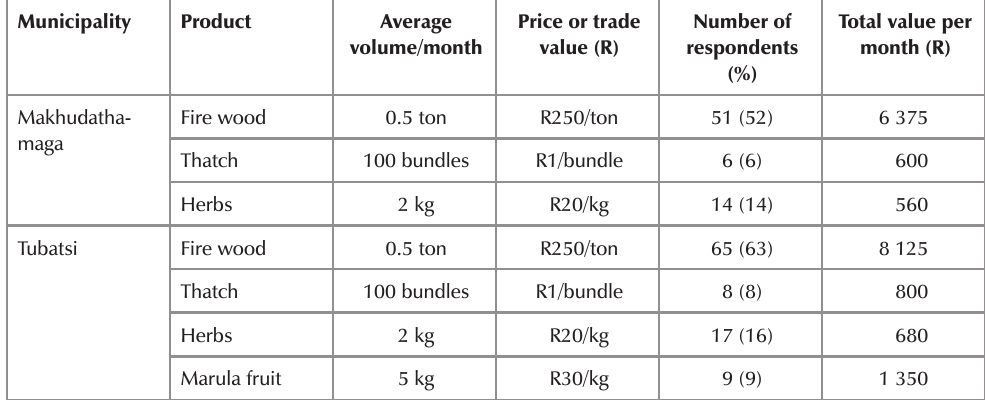
The volume and approximate monetary value of some natural products extracted by the respondents living in the GSMD